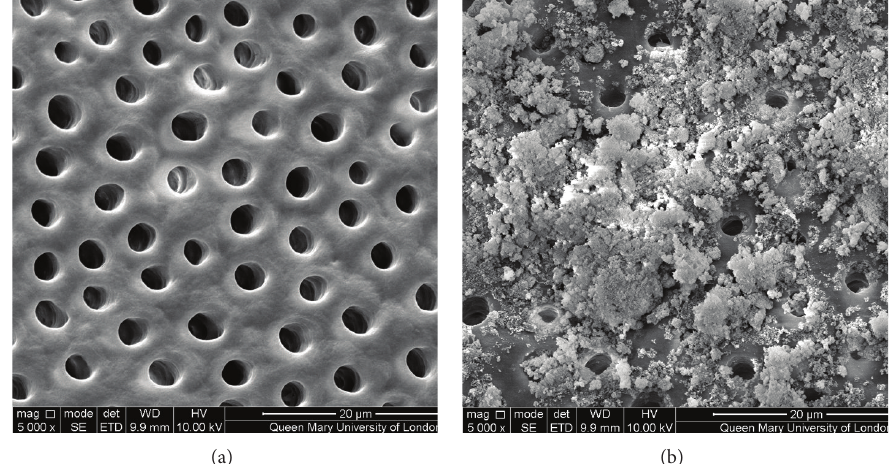
Figure 1: SEM images of dentine tubules treated with nHA oral rinse (UltraDEX HA Recalcifying oral rinse), before treatment (a) and after treatment (b).